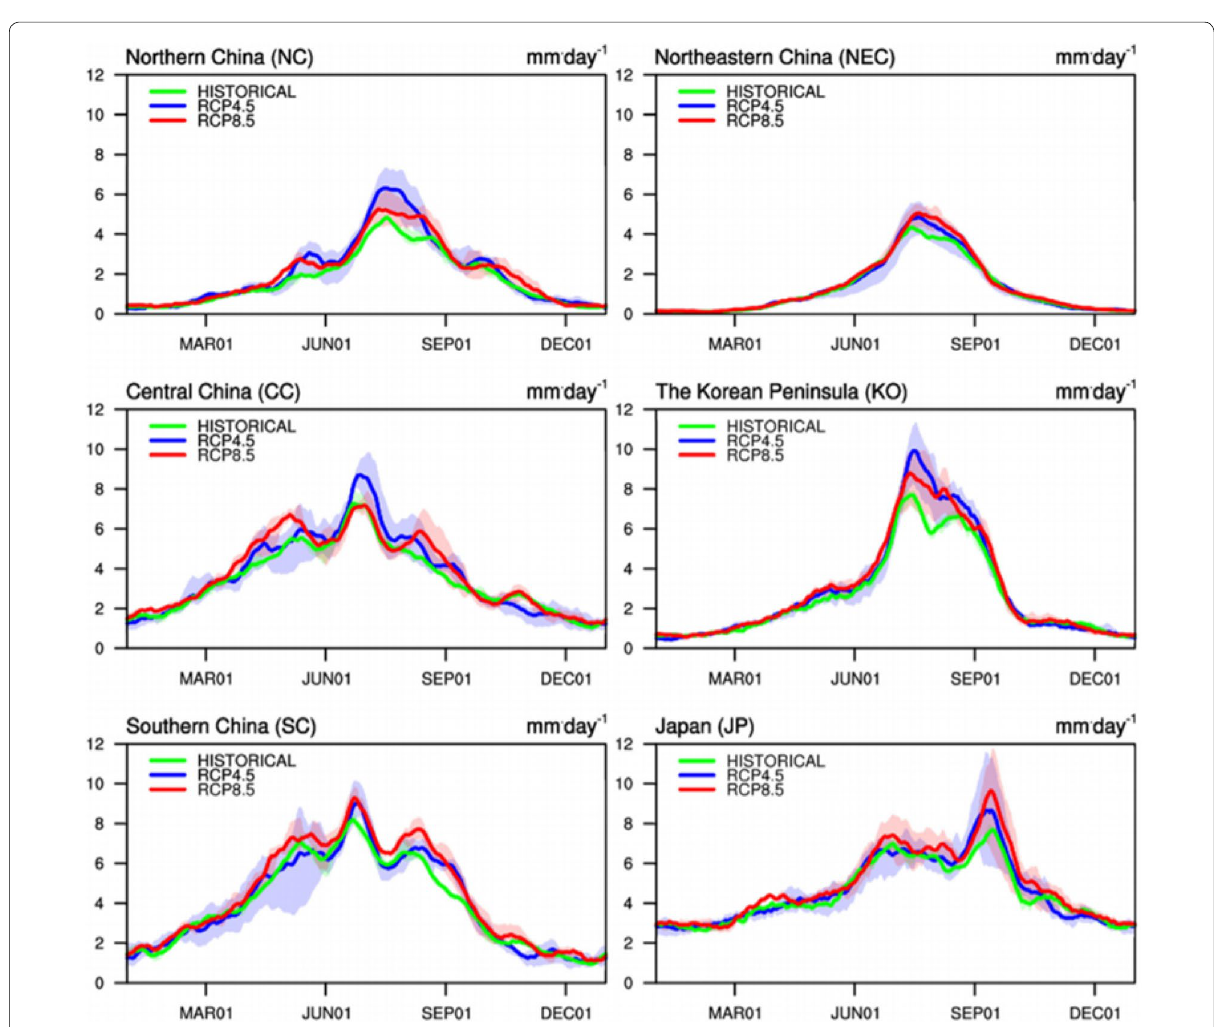
Fig. 8 The annual cycle of the area‑averaged precipitation (mm day − 1 ) over the six sub‑regions of the multi‑model ensemble in historical (green), RCP 4.5 (blue), and RCP 8.5 (red) experiments. Blue and red areas represent model spread between the RCMs in RCP 4.5 and RCP 8.5 experiments, respectively (adapted from Kim et al.